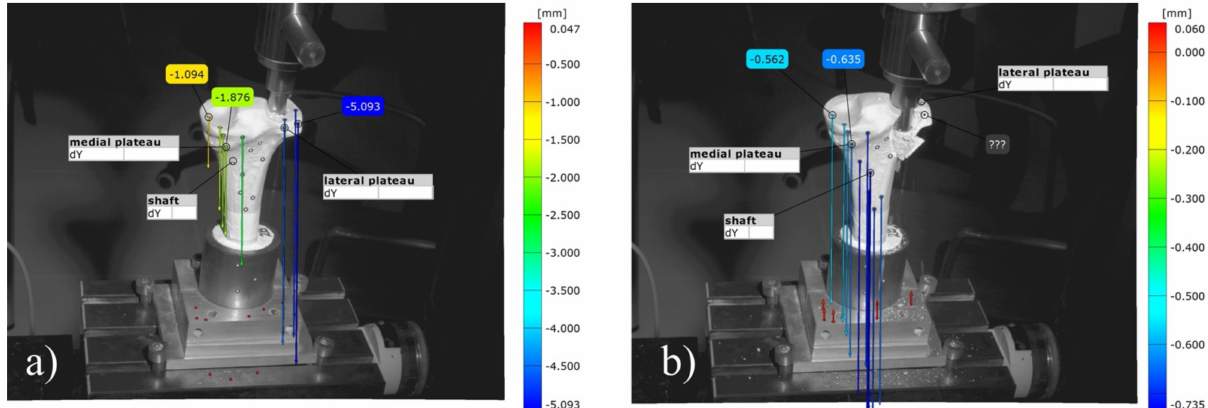
Figure 16. Images of the 3D metrology system of bone no. 28, bone defect filled with MPC_22.5. The most laterally placed optical reference point is also shown (blue): ( a ) Under the increasing load of the indenter, the cement is pressed out of the drill channel; ( b ) Representative failure mode for the group with bone cement only where fracture occurred on the lateral plateau with an intact tibial diaphysis.